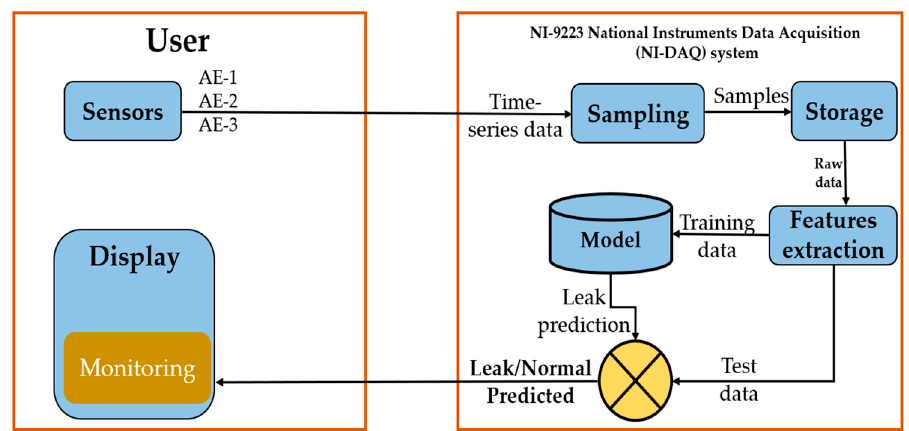
Figure 1. Overview of the proposed methodology for leak detection.